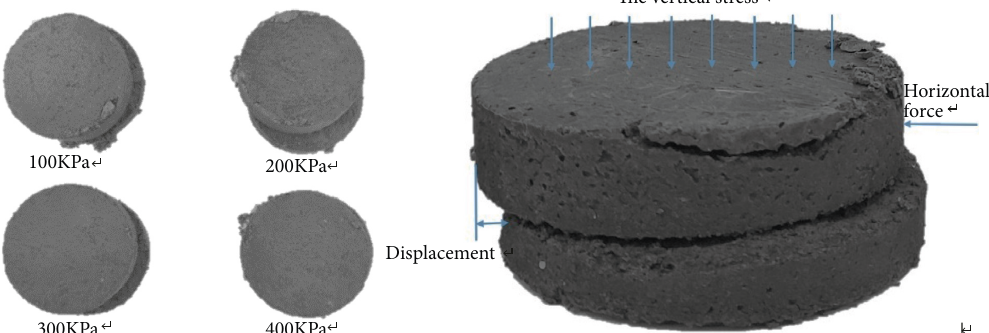
Figure 6: Lunar soil simulant samples after shear